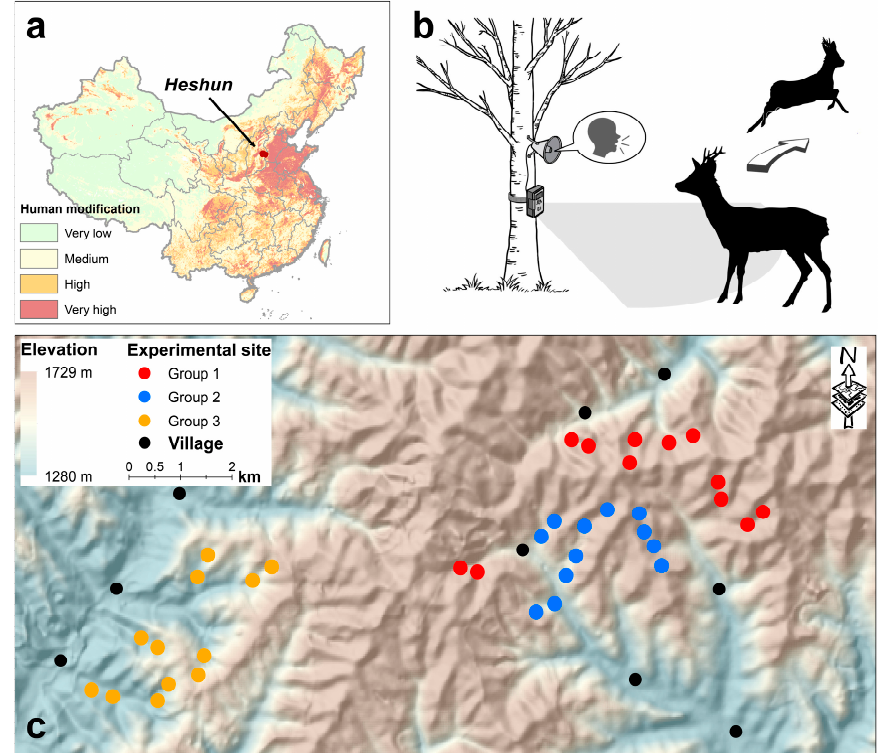
Figure 1. Location of the study area ( a ), experimental procedure ( b ) and the 36 experimental sites of three groups within the study area ( c ). Human modification index in Figure 1 ( a ) (obtained from Kennedy et al. [34]) ranges from 0 to 1 (very low: 0–0.1; moderate: 0.1–0.4; high: 0.4–0.7; very high: 0.7–1.0).